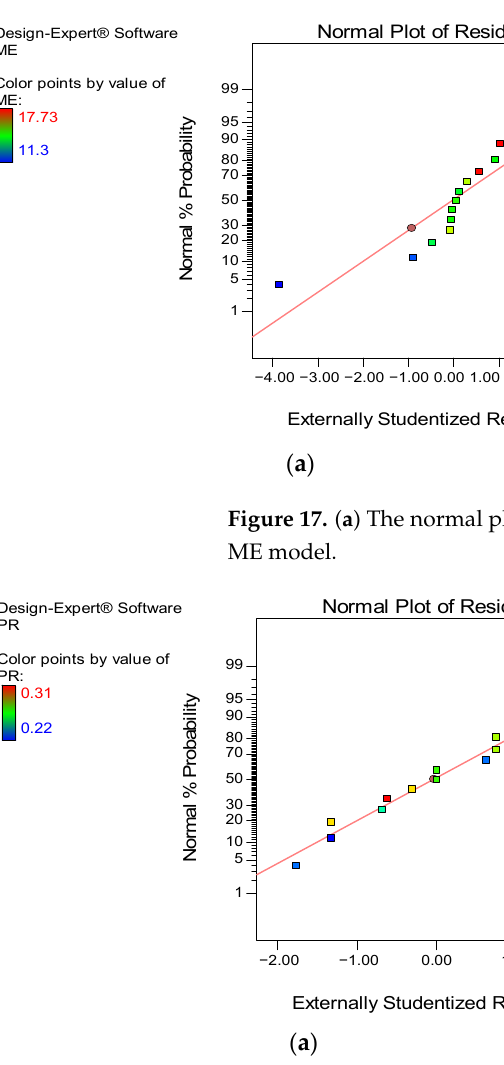
Figure 16. ( a ) The normal plot of residuals and ( b ) actual versus predicted plot for the OBA ‐ RECC CS model.